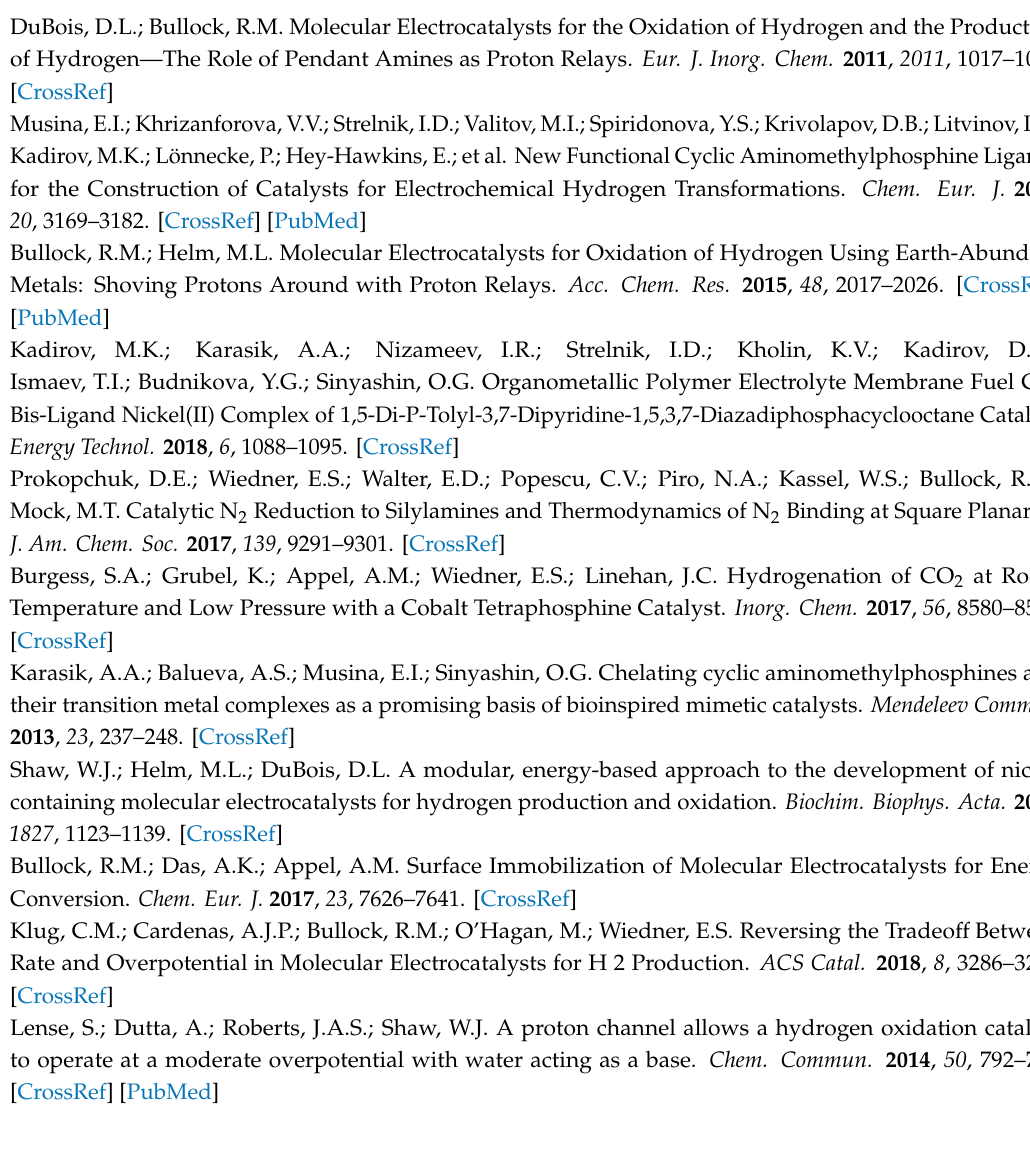
of 11b ; Figure S24: 1 H-NMR spectrum of 11b (the region of aliphatic protons); Figure S25: MALDI-MS spectrum of 11b ; Figure S26: TG / DSK diagram of 11b ; Figure S27: 31 P-NMR spectrum of 12 ; Figure S28: 1 H-NMR spectrum of 12 ; Figure S29: 1 H-NMR spectrum of 12 (the region of aliphatic protons); Figure S30: ESI-MS spectrum of 12 ; Figure S31: 31 P-NMR spectrum of 13 ; Figure S32: 1 H-NMR spectrum of 13 ; Figure S33: 1 H-NMR spectrum of 13 (the region of aromatic protons); Figure S34: ESI-MS spectrum of 13